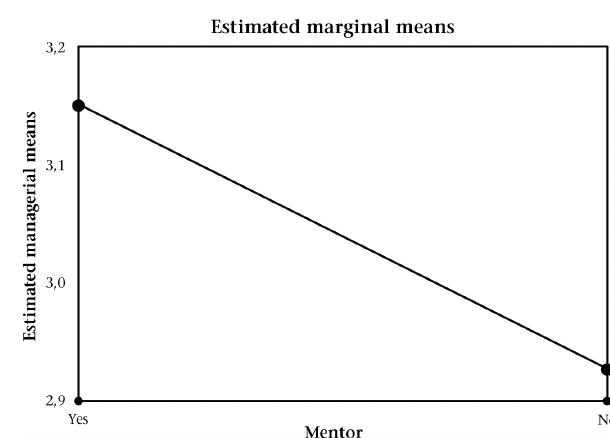
Figure 5: Biographical variable: Having a mentor or not as predictor of the perception of employment equity